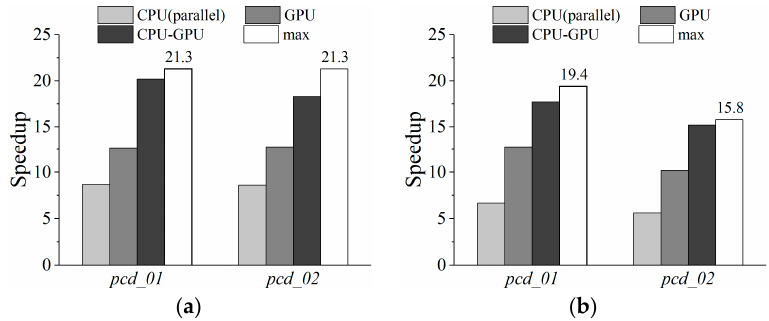
Figure 11. Speedups of different parallel execution modes for different point clouds. ( a ) hpc_01; ( b ) hpc_02.